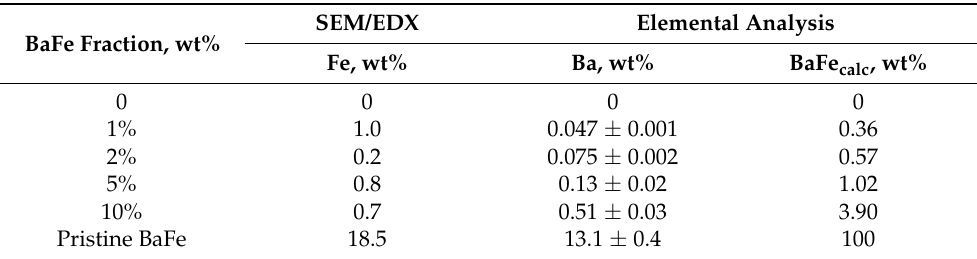
Table 2. Mechanical properties (cryogels), conductivity and specific surface area of PPy-G aerogel and PPy-G-BaFe aerogels, synthesized using various fractions of